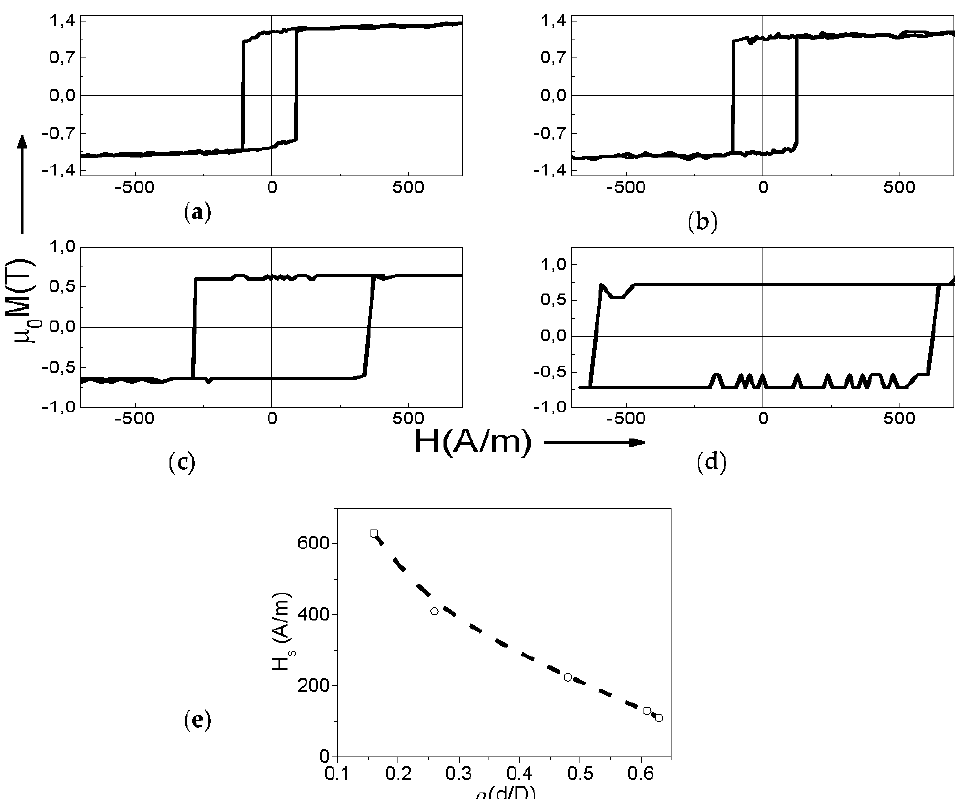
Figure 12. Hysteresis loops of Fe 70 B 15 Si 10 C 5 amorphous microwires with different metallic nucleus diameters, d , and total diameters, D : with ρ = 0.63; d = 15 µ m ( a ); ρ = 0.48; d = 10.8 µ m ( b ); ρ = 0.26; d = 6 µ m ( c ); ρ = 0.16; d = 3 µ m ( d ), and H s ( ρ ) dependence of the same microwires ( e ). The line in ( e ) is just a guide to the eyes. Adapted from [63]. Figure 7 Copyright © 2021 MDPI Publishing, Open Access.